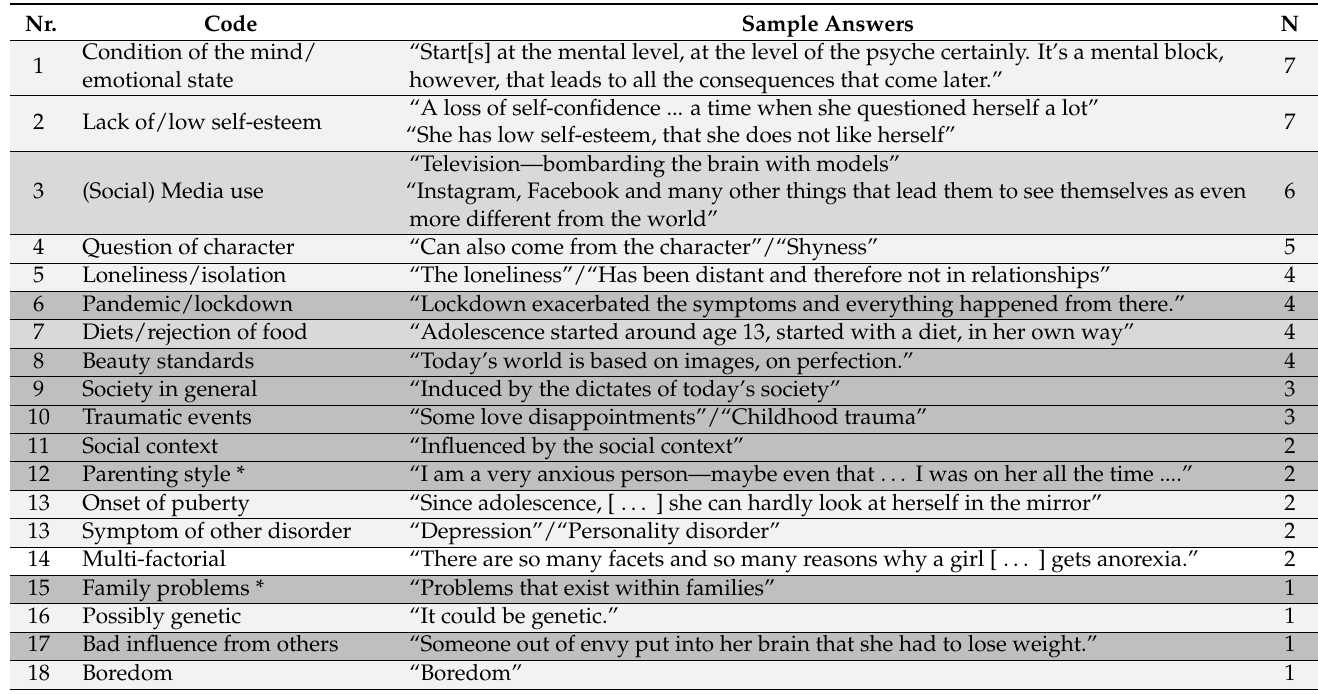
Table 1. Overview of assumed causes and frequencies (parental illness theories; N = 14): light grey = internal causes; grey = problematic behaviour; dark grey = external